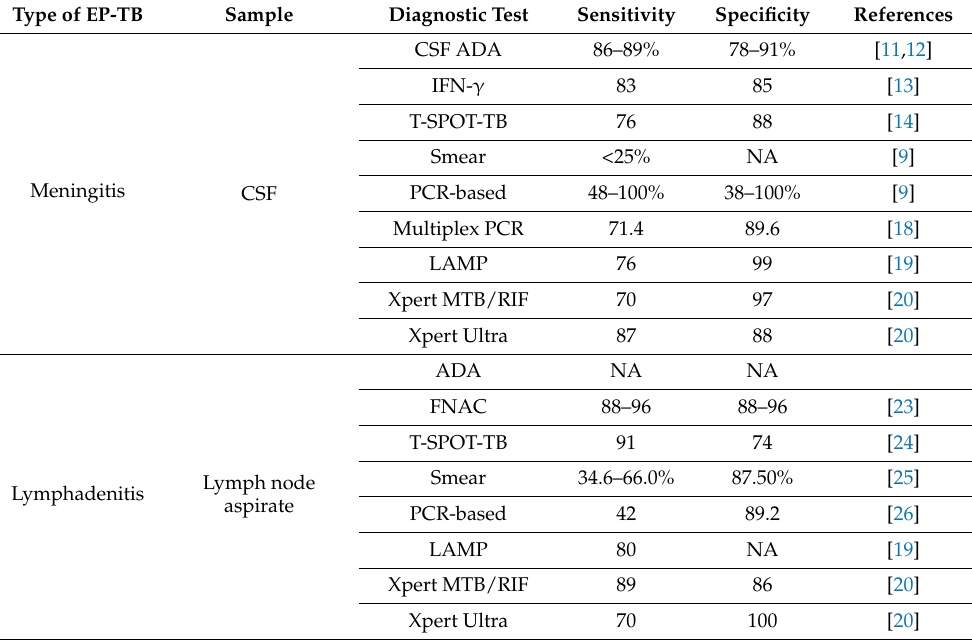
Table 2. Sensitivity and specificity of various diagnostic tests commonly used for